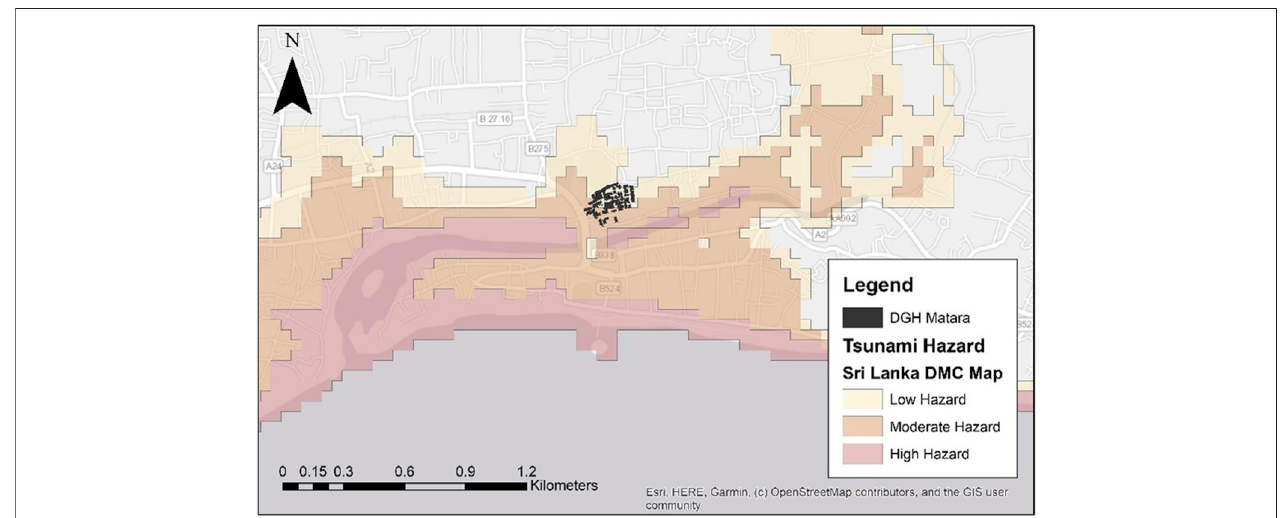
FIGURE 6 | Tsunami hazard map for the city of Matara (DMC, 2012).